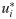
Locally uninvadable growth strategy (ui*) and the resulting growth patterns (xi*) under a me-vs-nature setting.Lines are model’s results and circles are observed values in human females. Results with (A-D) power and (E-H) exponential competence. (A,E) Uninvadable growth strategy vs age. (C,G) Resulting growth metabolic rate vs age. (B,F) Resulting body and tissue mass vs age. (D,H) Resulting brain and reproductive mass vs age. Lines and circles with the same color are respectively the model’s prediction and the observed values in modern human females [96]. Black circles are the observed (B,F) adult female body mass and (D,H) adult sex-averaged brain mass, either for late H. erectus [97] or Neanderthals [98, 99]. The growth strategy (A,E) has numerical jitter due to negligible numerical error (Fig B in S1 Appendix) and is here filtered for figure clarity (see unfiltered figure in Fig D in S1 Appendix).